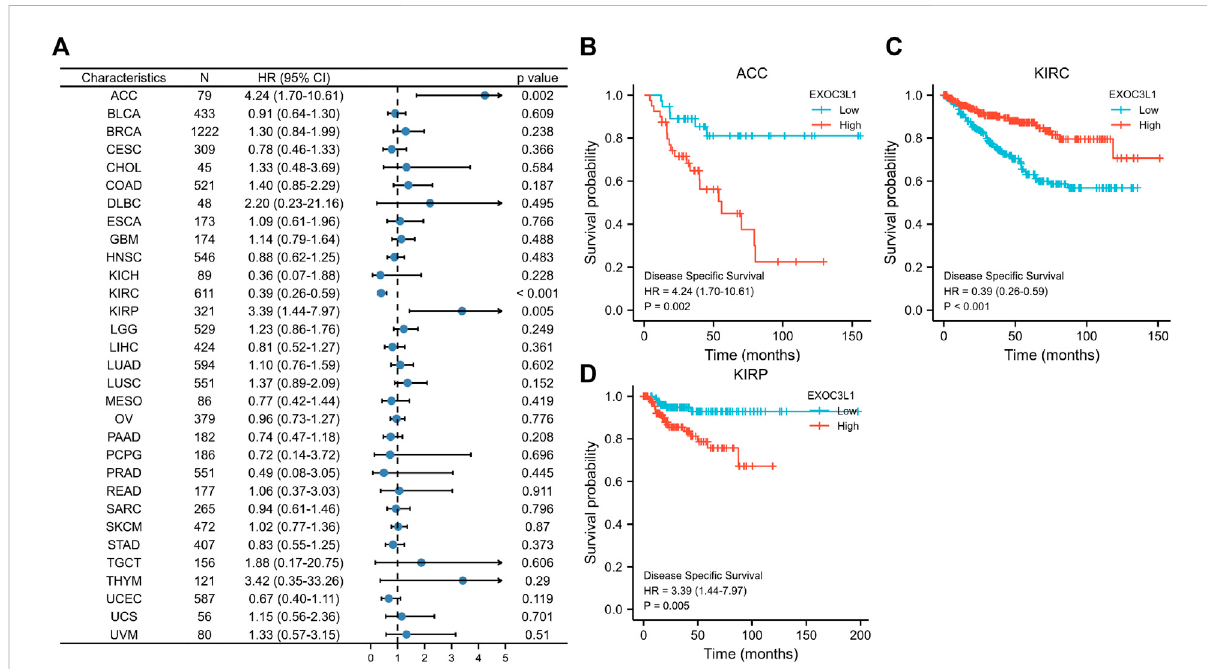
FIGURE 4 The relationship between EXOC3L1 expression and DSS in pan-cancer. (A) The associations of EXOC3L1 expression on DSS in various cancers were displayed by a forest diagram. (B – D) Survival curves of EXOC3L1 on DSS in ACC, KIRC and KIRP, respectively.